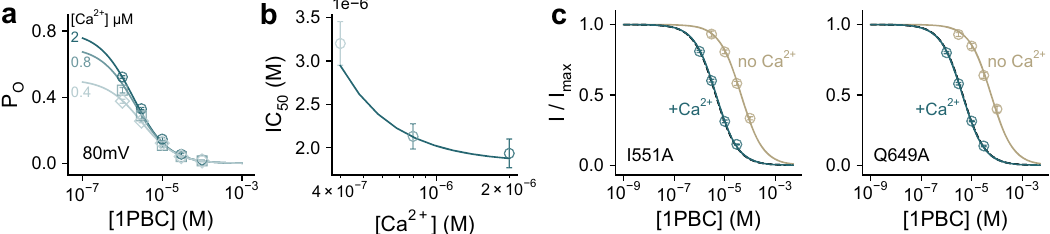
Fig. 2 1PBC block is state-dependent. a Concentration-response relations of 1PBC at the indicated intracellular Ca 2 + concentrations at 80 mV. Data are scaled according to the open probability of the channel in the absence of 1PBC as determined previously 28 . Data are averages of 6, 5, and 7 biological replicates for 2 µ M, 800 nM, and 400 nM Ca 2 + respectively, errors are SEM. b IC 50 values at the plotted intracellular Ca 2 + concentrations at 80 mV, which were obtained via an empirical fi t to the Hill equation on the data shown in ( a ). Shown are the best- fi t values, errors are 95% CI. a , b Solid lines are a global fi t to an open-channel block mechanism (Eqs. 4 – 9), with estimated parameters K d 1PBC = 3.6 ± 0.29 µ M at zero mV and apparent valence δ b = 0.27 ± 0.025 (see “ Methods ” ). c Concentration-response relations of 1PBC at 0 mV at zero and 2 µ M intracellular Ca 2 + for the constitutively active mutants I551A and Q649A. Data are averages of 6, 9, 7, and 7 biological replicates for I551A at 2 µ M Ca 2 + , I551A at 0 Ca 2 + , Q649A at 2 µ M Ca 2 + , and Q649A at 0 Ca 2 + respectively, errors are SEM. Solid lines are fi ts to the Hill equation. Dashed lines are the relation of